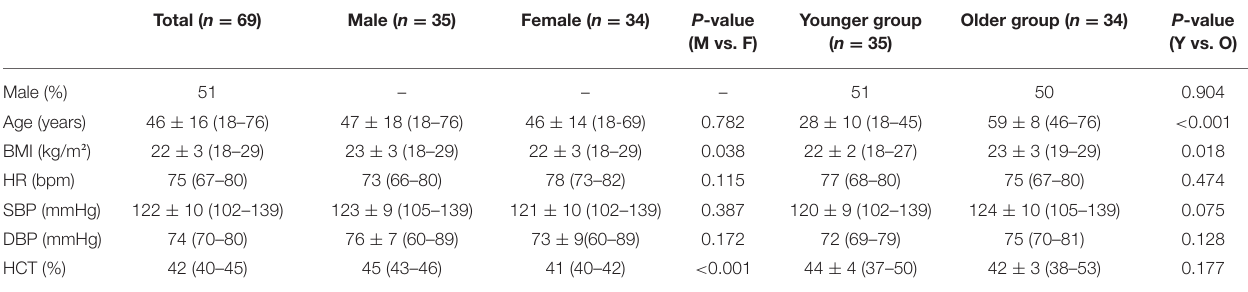
TABLE 1 | Demographic characteristics of a cohort of healthy adult Chinese volunteers.